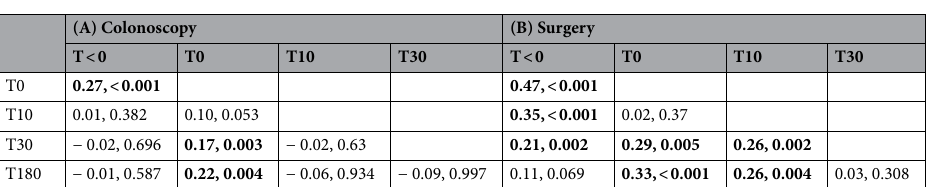
Table 3. ANOSIM comparison of Bray–Curtis dissimilarities. ANOSIM R-values and P values are presented in the matrix for (A) colonoscopy and (B) surgical samples. Bold indicates significant P value (< 0.05).